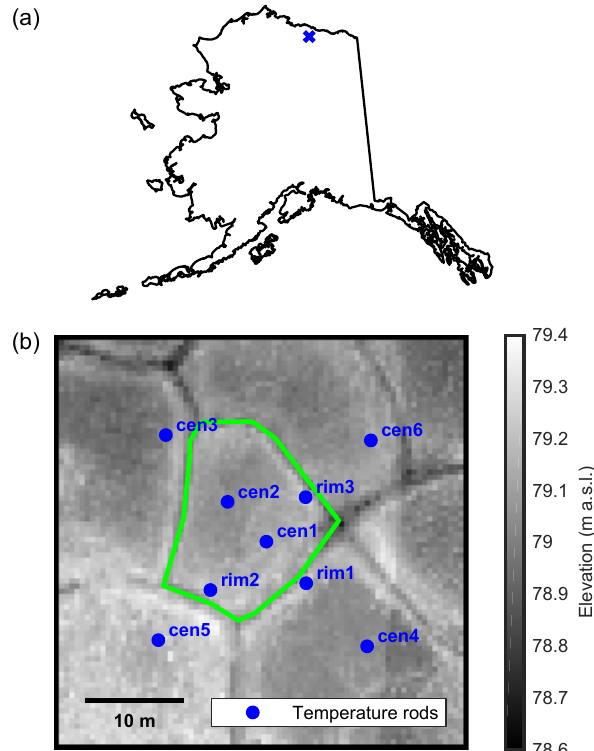
Figure 1. Location of field site (a) and 50cm resolution lidar DEM with ice wedge polygon extent and temperature sensor rod locations indicated (b)